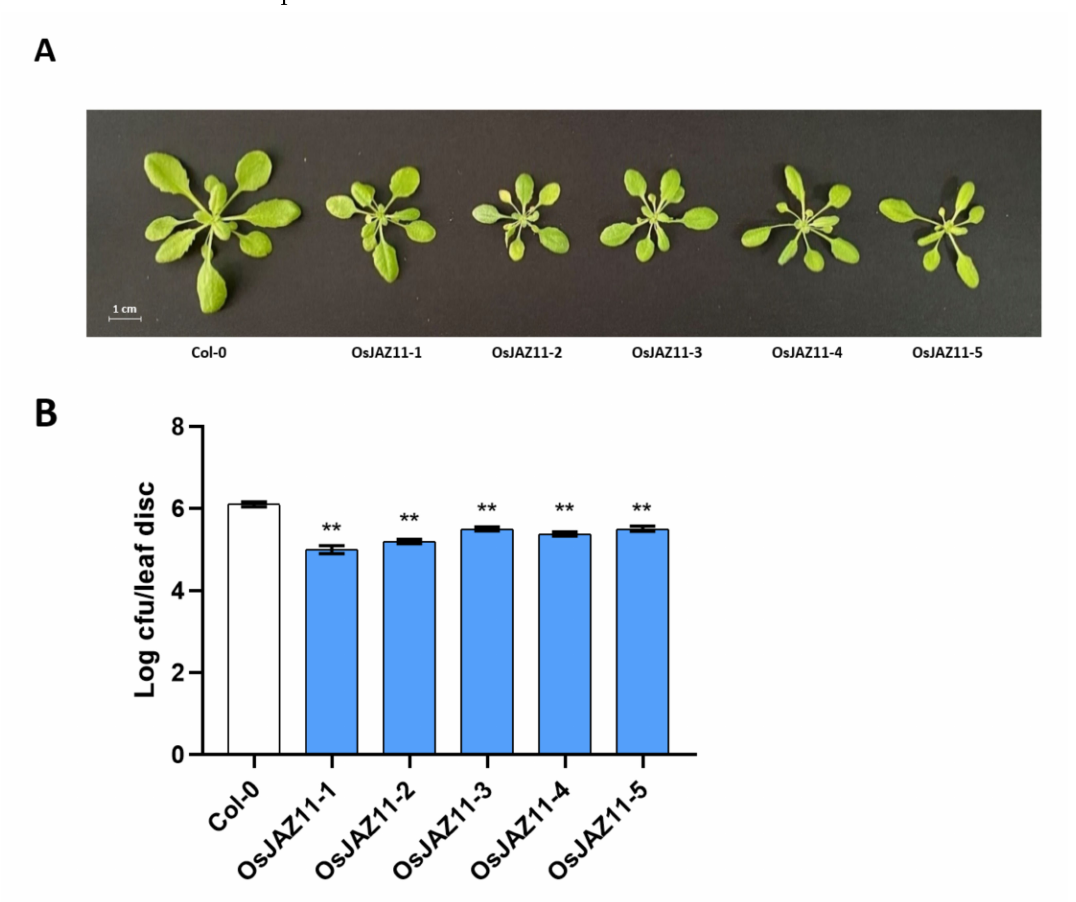
Figure 4. Different lines of OsJAZ11 OE are smaller than Col-0 and have stronger resistance to Pst DC3000. ( A ) phenotypic profiles of Col-0 and five different lines of OsJAZ11 OE plants grown for 25 days. The Arabidopsis thaliana plants were grown in a growth chamber at 22 ◦ C under 16 h of light (100 µ E · m − 2 · s − 1 ) and 8 h of darkness. ( B ) Three- to four-week-old plants were syringe-infiltrated with the Pst DC3000 bacterium (1 × 10 4 CFU · mL − 1 ) and the bacterial population in the leaves was enumerated at two days after inoculation. Data shown are the means ± SE ( n = 12) (** p < 0.01, Student’s t